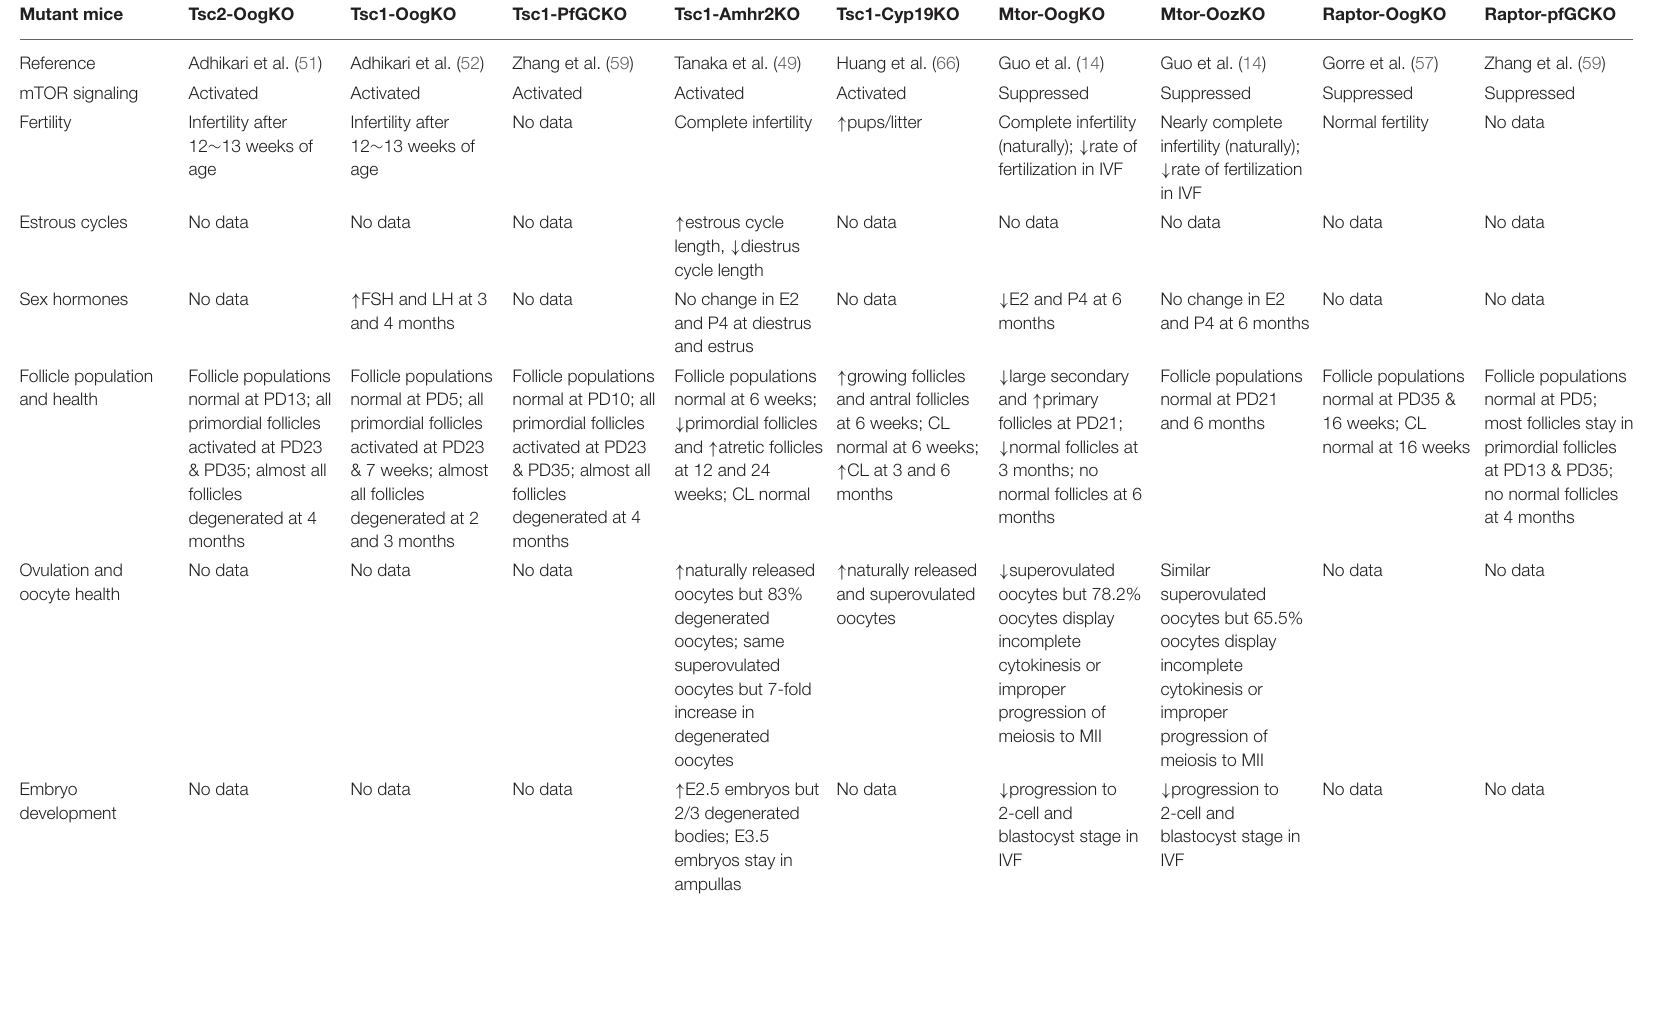
TABLE 1 | Ovarian-specific effects of altered mTOR